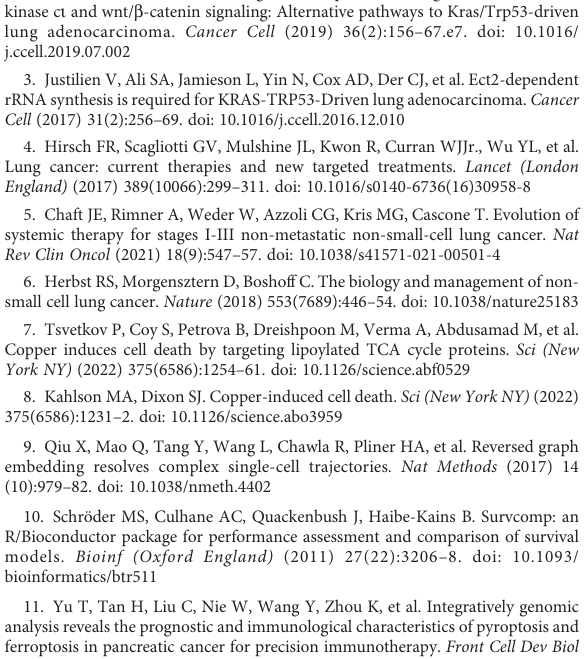
SUPPLEMENTARY FIGURE 1 External validation of CRGs-related deep learning models. (A) KM survival curves of the high-risk and low-risk groups in the (A) GSE30219, (B) GSE42127, and (C) GSE72094 cohorts. (D) Patients ’ survival status in the GSE30219, (E) GSE42127, and (F) GSE72094 cohorts. (G) ROC curves of risk score at 1 year, 3 years, and 5 in the GSE30219, (H) GSE42127, and (I) GSE72094 cohorts. SUPPLEMENTARY FIGURE 2 Subgroup Cox analysis of FRS. Subgroup Cox regression analysis of risk score in (A) TCGA cohort, (B) GSE30219, (C) GSE42127, and (D) GSE72094 cohorts. SUPPLEMENTARY FIGURE 3 CRGs-related deep learning model for treatment decision. (A) Predicted IC50 values of the fi ve commonly used drugs in the two risk groups in the (A) GSE30219, (B) GSE42127, and (C) GSE72094 cohorts. Differences in immunotherapy response predicted by the TIDE algorithm between both risk groups in the (D) GSE30219, (E) GSE42127, and (F) GSE72094 cohorts. Differences in immunotherapy response between both risk groups were predicted by subclass mapping in the (G) GSE30219, (H) GSE42127, and (I) GSE72094